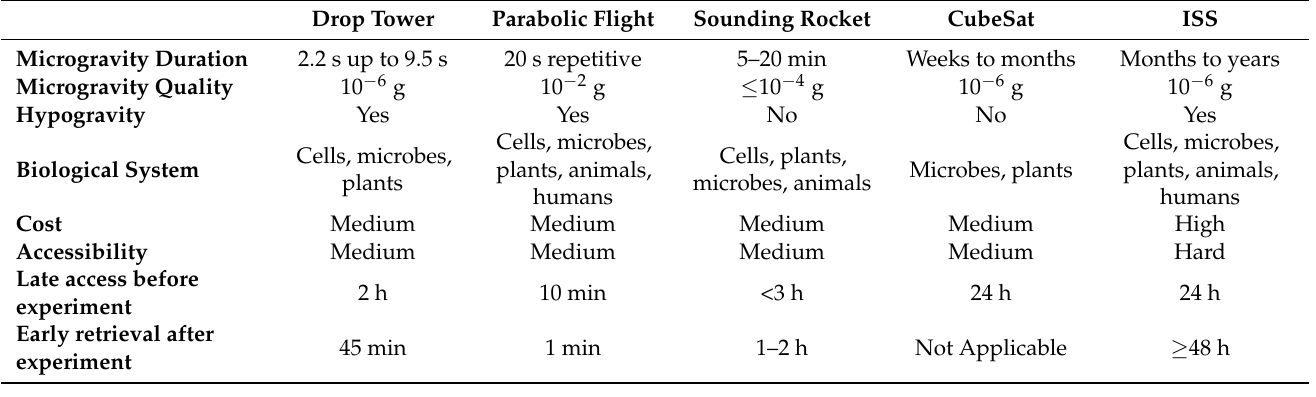
Table 3. Specifications of non-orbiting and orbiting microgravity facilities. ISS, International Space Station.